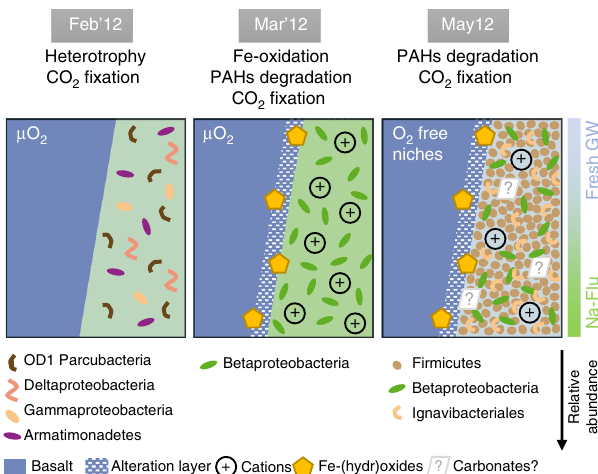
Fig. 7 Summary of the impact of the pure CO 2 injection on the bacterial community hosted at the basaltic Carb fi x1 CCS site. The initial population in the groundwater sampled in monitoring well HN-04 was still fl ourishing in February 2012 (Feb ’ 12) and was mainly composed of heterotrophs living under aerophilic to microaerophilic conditions. In March 2012 (Mar ’ 12), groundwater acidi fi cation induced by arrival of the fast- fl owing fraction of the pure-CO 2 injectant severely reduced bacterial richness, provoked the dissolution of the host-basalt and the release of mineral-forming cations and likely polyaromatic hydrocarbons (PAHs). Fe 2+ and other ions (e.g., Ca, Mg, Zn) became bioavailable to the ecosystem, as a result favoring